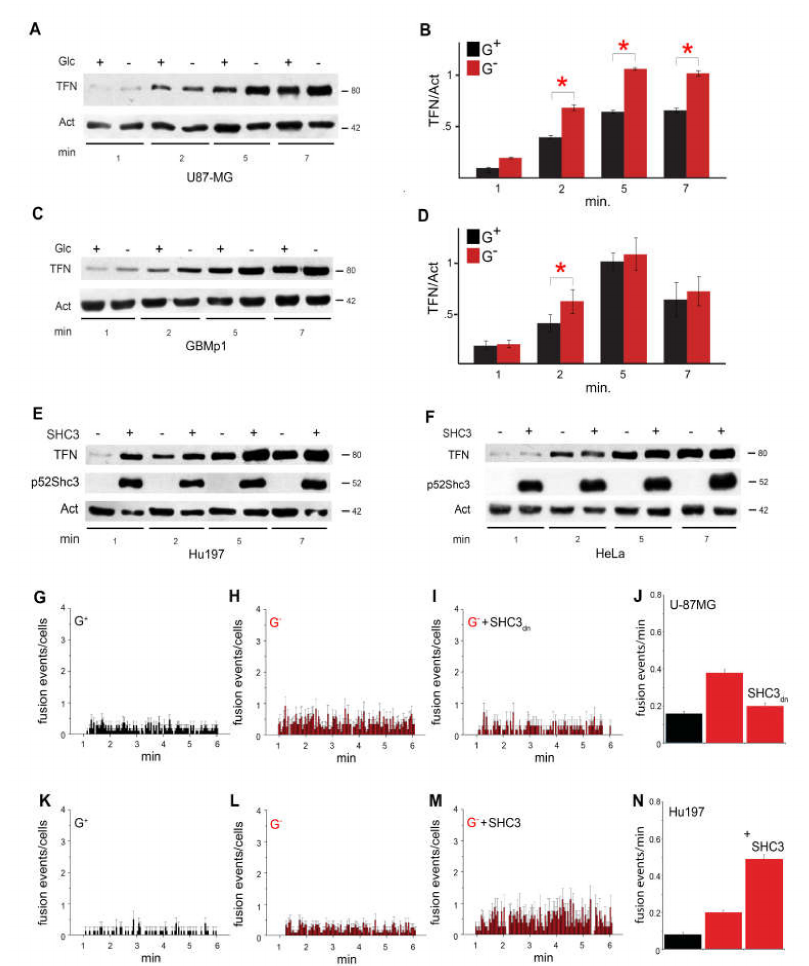
Figure 4. SHC3 modulates fusion of GLUTs containing vesicles to the membrane. ( A , C ) Western blot showing the time course of transferrin uptake by U-87 MG cells ( A ) and by short term cultures